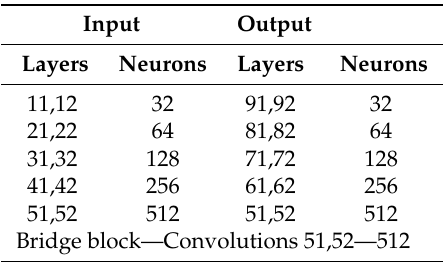
Table 1. Number of neurons in each